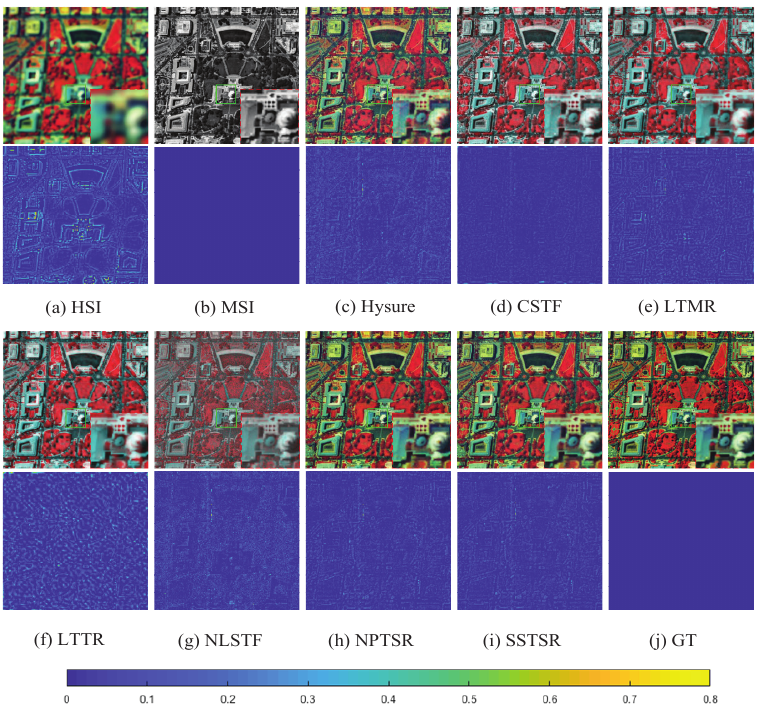
Figure 6. The first and third rows show the false color images (composited by bands 65, 45, 5) of the comparison methods on the Washington DC Mall data set. The second and fourth rows show the normalized residual images of the comparison methods at